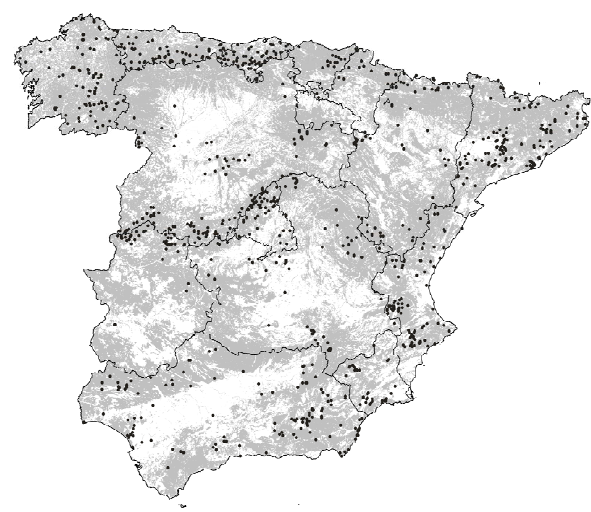
Fig. 1. Location of the 942 profiles established in non-crop areas (grey colour) of peninsular Spain used in the present